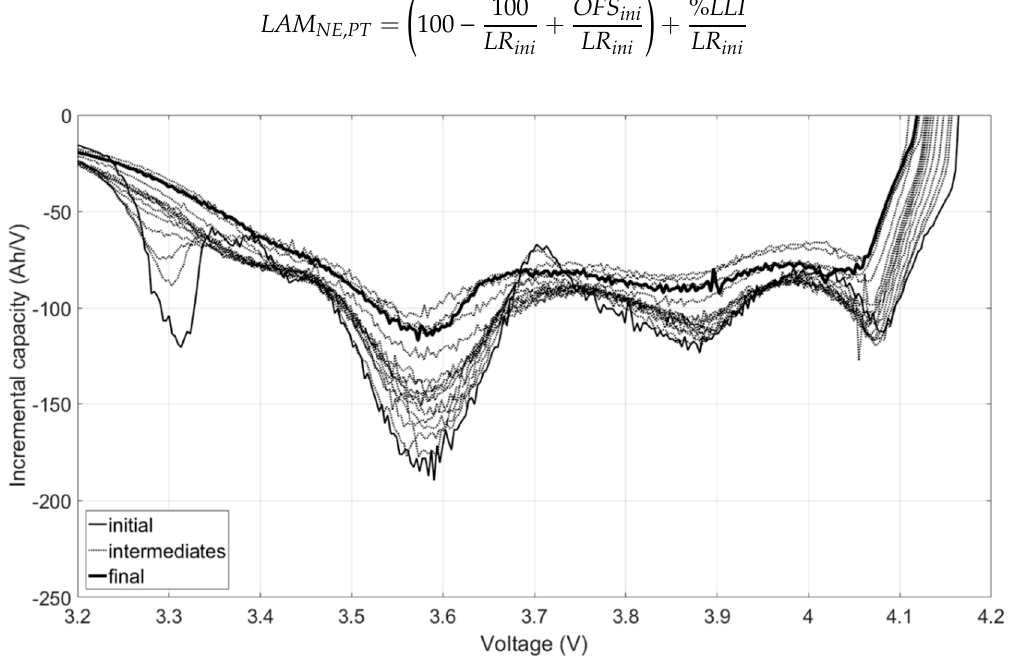
Figure 10. Representative IC curve evolution of a cell aged to failure (>20% capacity loss) during discharge.